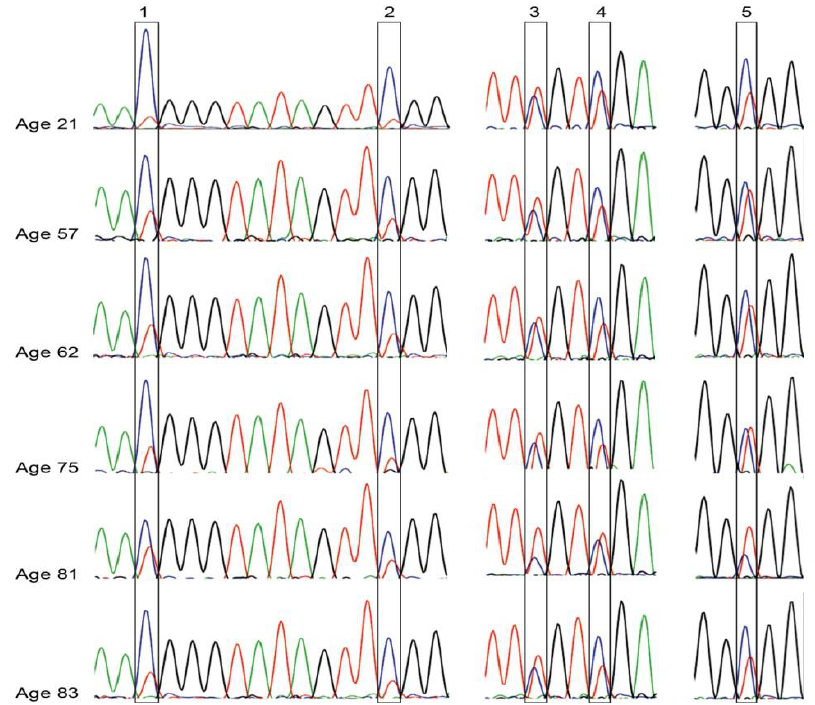
Figure 2. Representative DNA methylation of KCNK9 -US1 DMR in non-cancerous breast tissue. Commercially obtained breast genomic DNA (Biochain, Newark, CA, USA) was obtained for analysis. The results are shown from six women, ranging in age from 21 to 83 years old.